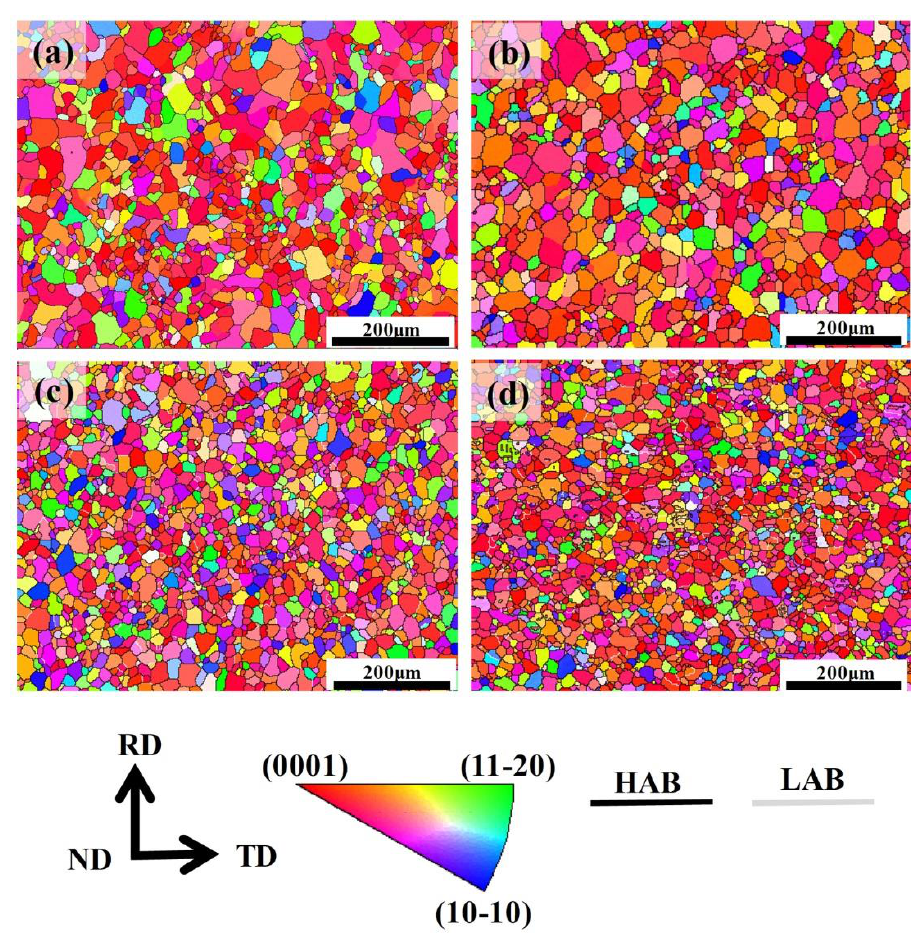
Figure 4. Inverse pole figure maps of different samples after annealing: ( a ) upper surface of HTRA sample; ( b ) mid-layer of HTRA sample; ( c ) upper surface of HTR-CBA sample; ( d ) mid-layer of HTR-CBA sample.